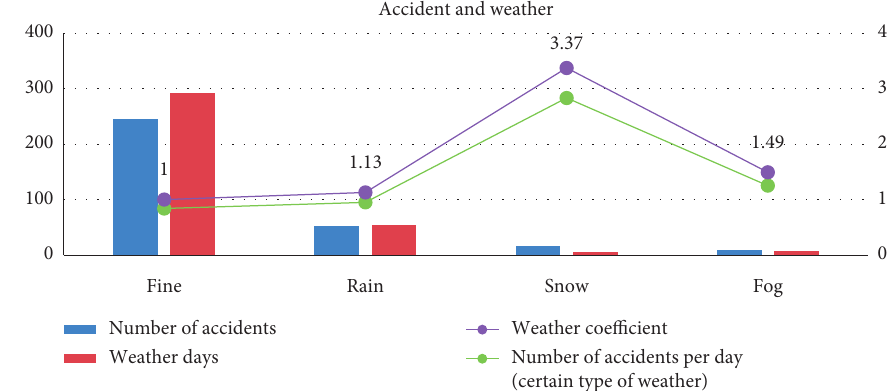
Figure 5: Coefficient between weather and